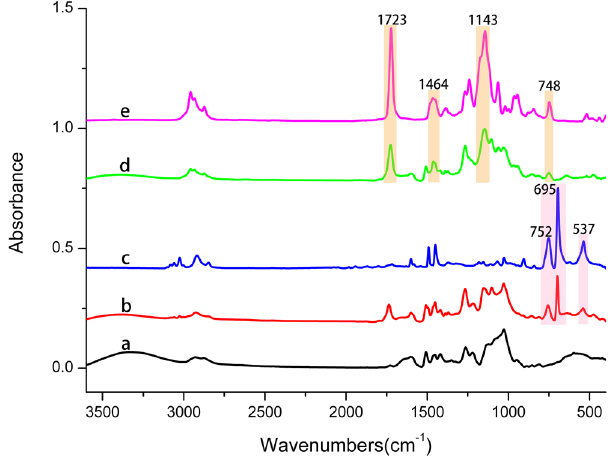
Figure 2. FTIR spectra of ( a ) untreated archaeological wood, ( b ) wood-g-PSt (sample PSt1), ( c ) PSt, ( d ) wood- g-PBMA (sample PBMA3) and ( e )